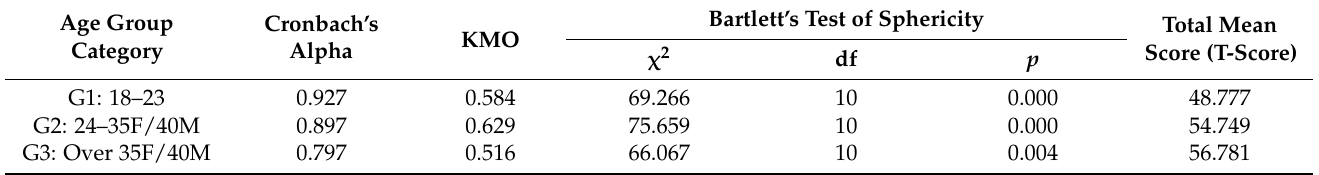
Table 7. Statistical analysis of the data of the Personal Autonomy Questionnaire (PAQ).